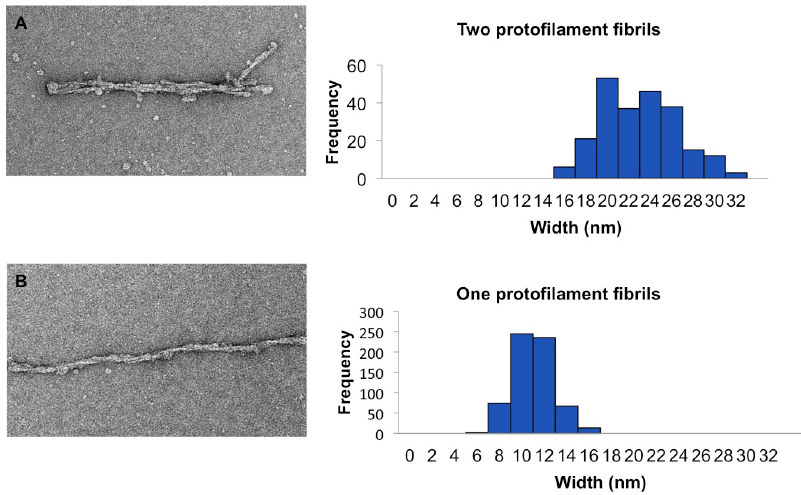
Fig 5. Width distribution of L-type BSE fibrils. ( A ) A sample electron micrograph and histogram of the maximum width of 231 two-protofilament L-type BSE fibrils. ( B ) A sample electron micrograph and histogram of the maximum width of 636 one-protofilament L-type BSE fibrils. The width measurements were performed using EMAN’s boxer program.